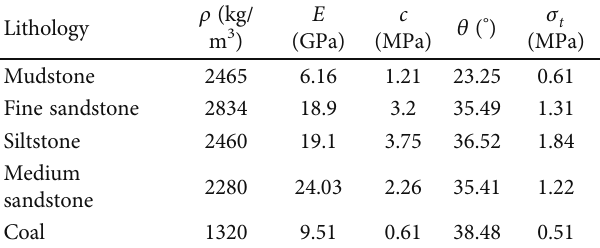
Table 1: Mechanical parameters of various rock masses of the numerical